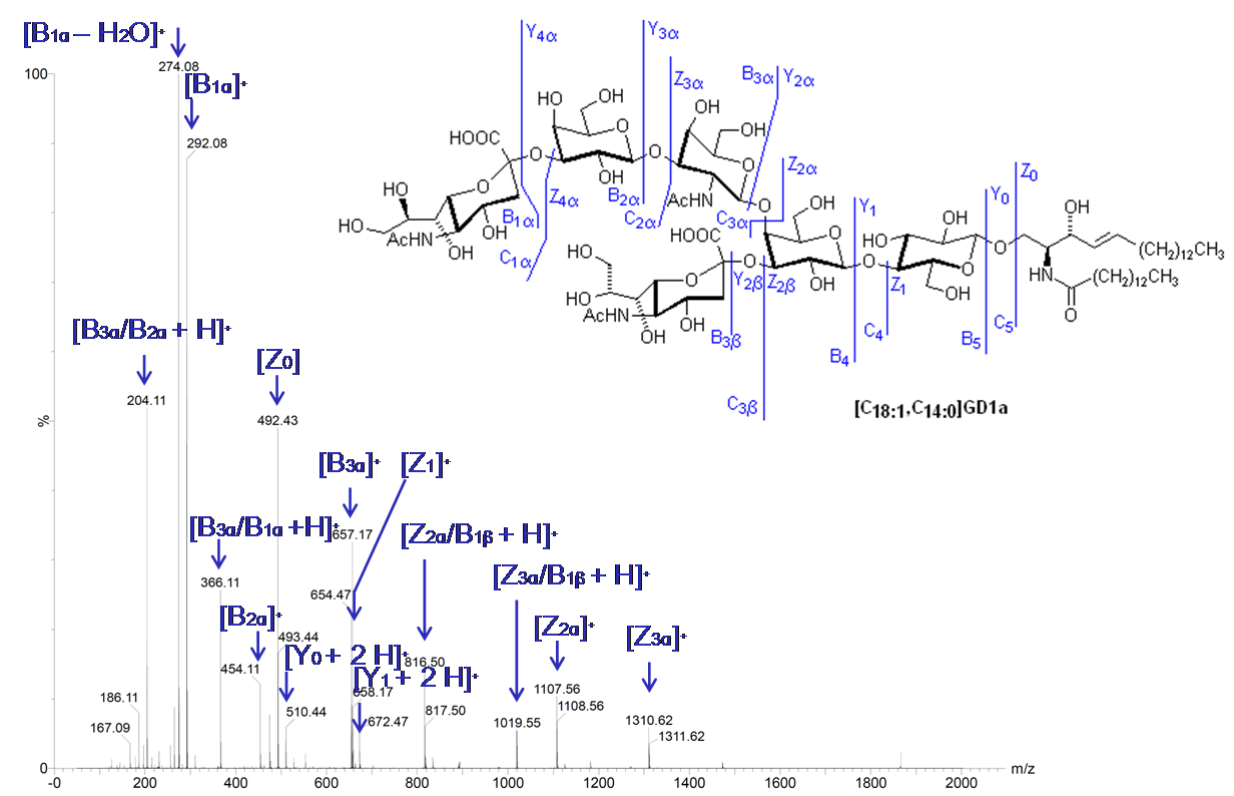
Figure 8. Collision induced dissociation (CID) of the ganglioside standard substance [C ,C ]GD1a. Fragmentation of the [M+2H] 2+ signal at m/z = 891,37 in the positive 18:1 14:0 mode is shown (M. Gantner, T. Kolter, unpublished). For the nomenclature of fragments, compare